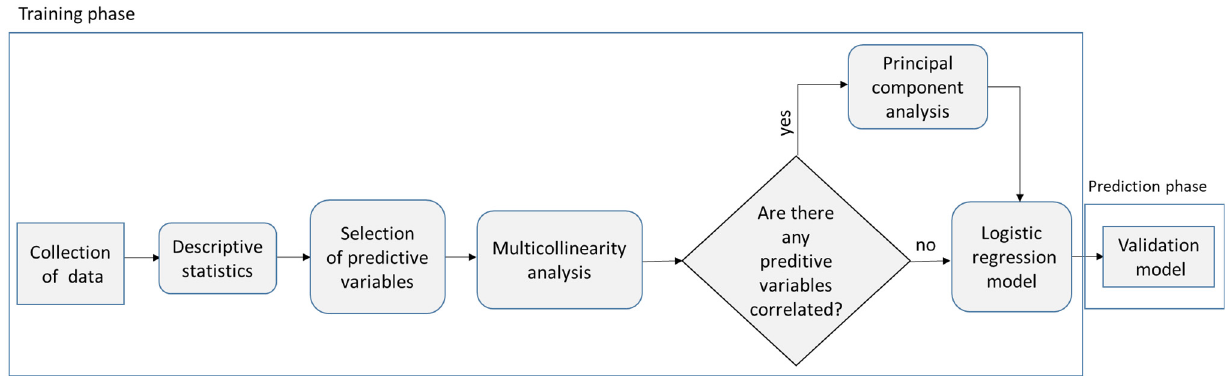
Figure 6. Block diagram of the data-driven approach to predict railway track condition. To forecast railway track condition, represented by C , the logistic function was chosen. Logistic binary regression expresses the probability of occurrence of a defined track quality condition by taking values 0 (good track) or 1 (track with defect). This probabilistic model also performs better than the linear regression, which is not appropriate for modeling variables that are not normally distributed. Considering the logistic binary regression, the expressed by Equation